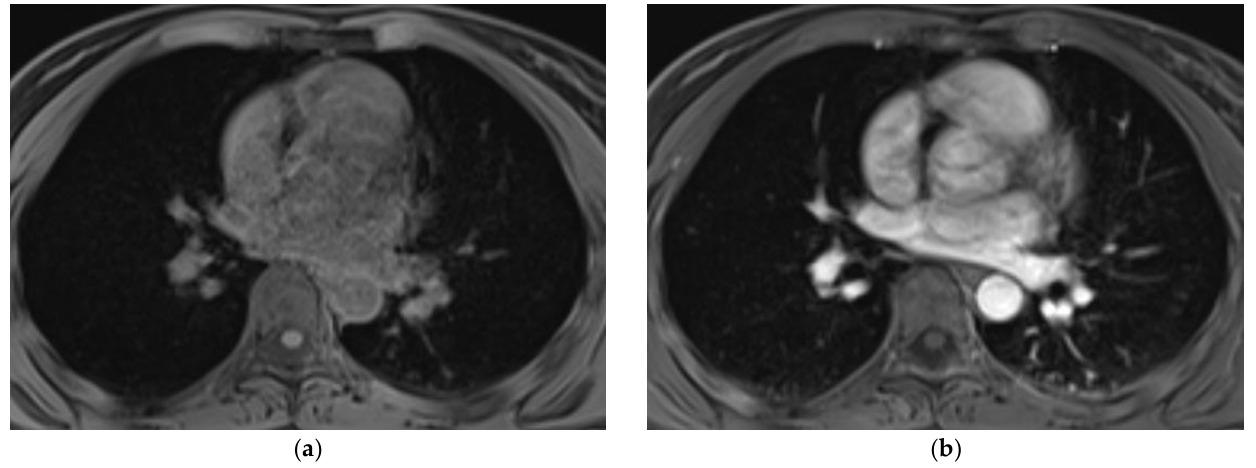
Figure 1. Images illustrating the 20-min-WB-MRI-protocol: example of axial T1-weighted (T1w) TSE Dixon of the neck ( a ), coronal T2-weighted (T2w) HASTE of the upper abdomen ( b ), simultaneous multislice diffusion-weighted imaging of the abdomen and pelvis ( c ), and axial pre- ( d ) and post-contrast T1w VIBE Dixon from thorax to pelvis ( e ) in a 36-year old patient with malignant melanoma and currently no evidence of disease. Note that the sharpness of the anatomic structures, such as the liver vessels (arrow), was rated as excellent. Please note that the images have been cropped, as the skin tissue was part of the acquisition.